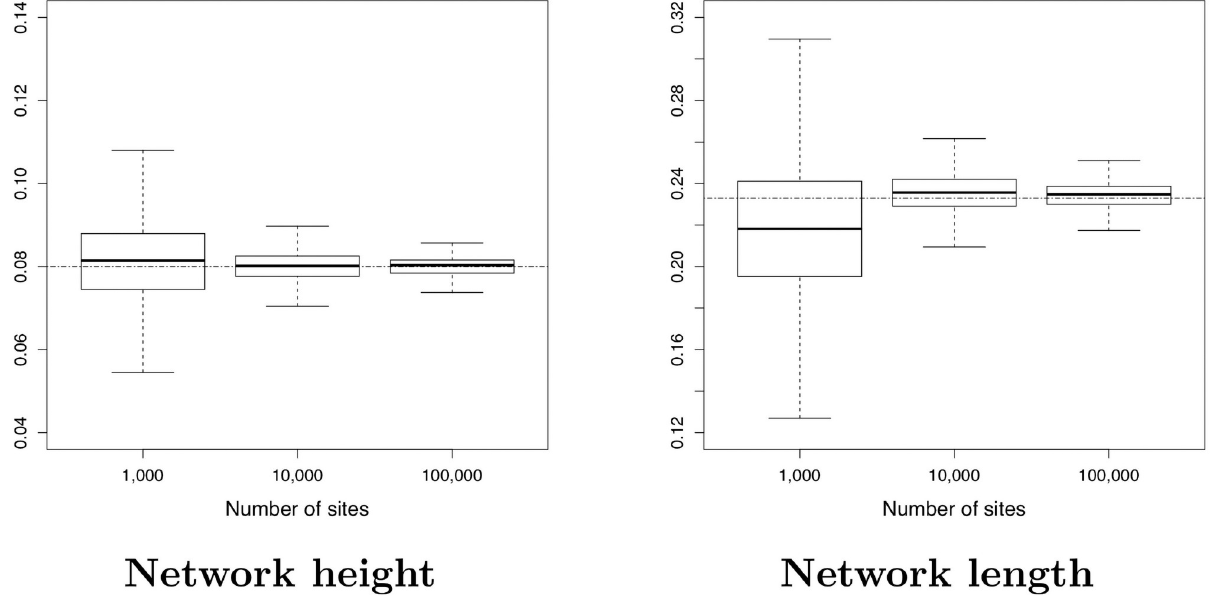
Fig 10. Estimated height and length for network A (see Fig 7), as a function of the number of sites. Heights and lengths are measured in units of expected number of mutations per site. True values are given by the dashed horizontal lines. Two lineages per species were simulated. Constant sites are included in the analysis, and 20 replicates are considered for each simulation set up (criterion ESS > 200; θ * Γ (1, 200), d � E ð 0 : 1 Þ , r * Beta(1, 1), t � E ð 10 Þ for the priors, number of reticulations bounded by 2 when exploring the network space). 0